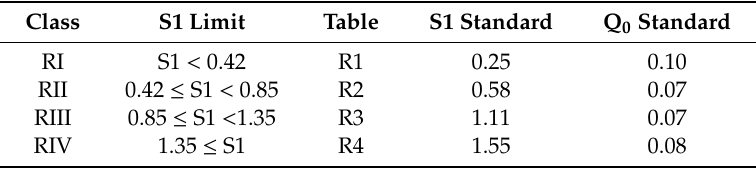
Table 1. R-classification system for dry road surfaces established by the CIE. Class